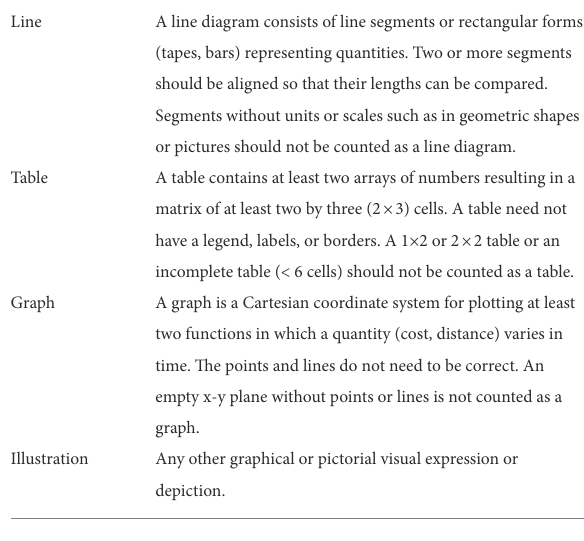
TABLE 2 Analysis grid for scoring constructed diagrams. Line A line diagram consists of line segments or rectangular forms (tapes, bars) representing quantities. Two or more segments should be aligned so that their lengths can be compared. Segments without units or scales such as in geometric shapes or pictures should not be counted as a line diagram. A table contains at least two arrays of numbers resulting in a matrix of at least two by three (2 × 3) cells. A table need not